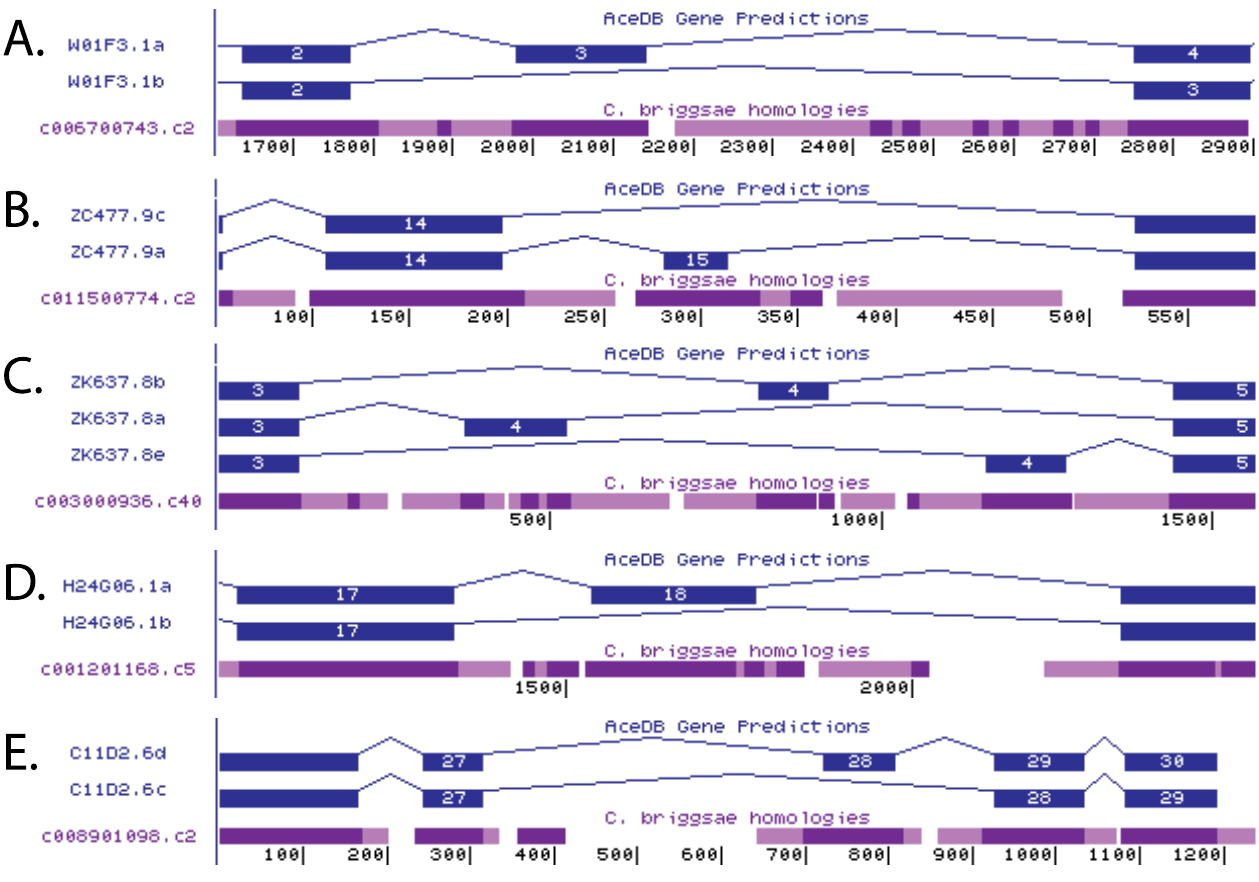
Figure 1. Images from the Intronerator Genome Browser Showing Alternatively Spliced Genes Gene isoforms predicted by the Wormbase Consortium are shown in blue, and WABA homology alignments for C. briggsae to this region of the C. elegans genome are shown in purple. Dark purple indicates a region of WABA high homology, light purple corresponds to low homology, and white indicates no homology between species. Regions of alternatively spliced genes: (A) W01F3.1, (B) ZC477.9, (C) ZK637.8, (D) H24G06.1, and (E) C11D2.6 are shown. DOI: